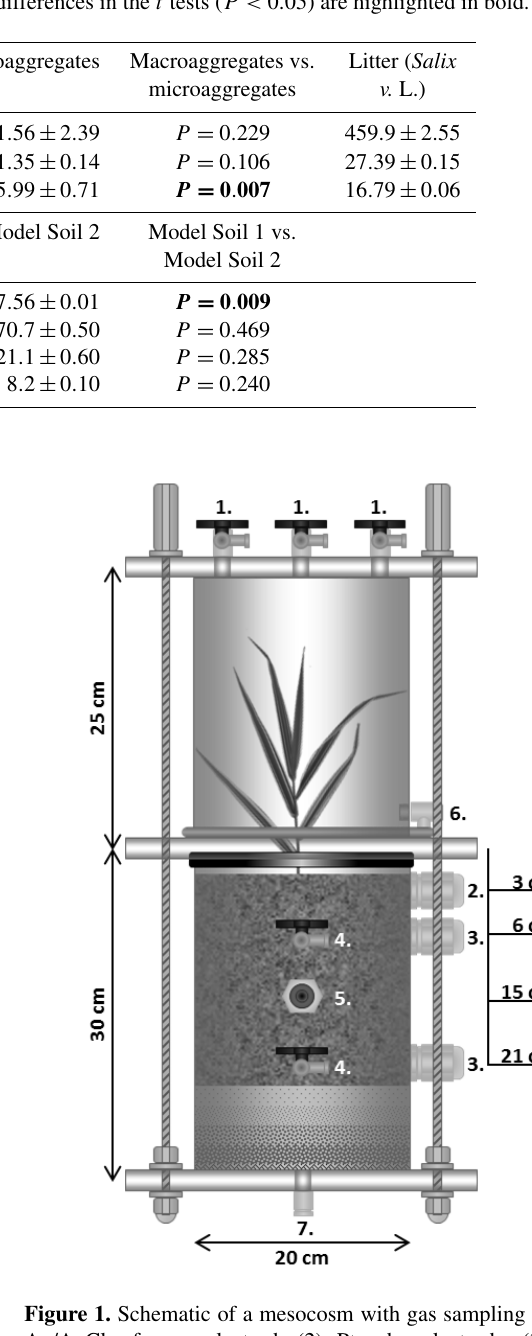
Table 1. Physicochemical properties of the two aggregate size fractions (macroaggregates and microaggregates) and added leaf litter. C org and TN of the aggregates were measured in triplicates. The leaf litter was analysed in quadruplicates. Final pH and texture of Model Soil 1 and Model Soil 2 were measured in duplicates (means ± SD). Significant differences in the t tests ( P < 0 . 05) are highlighted in bold.